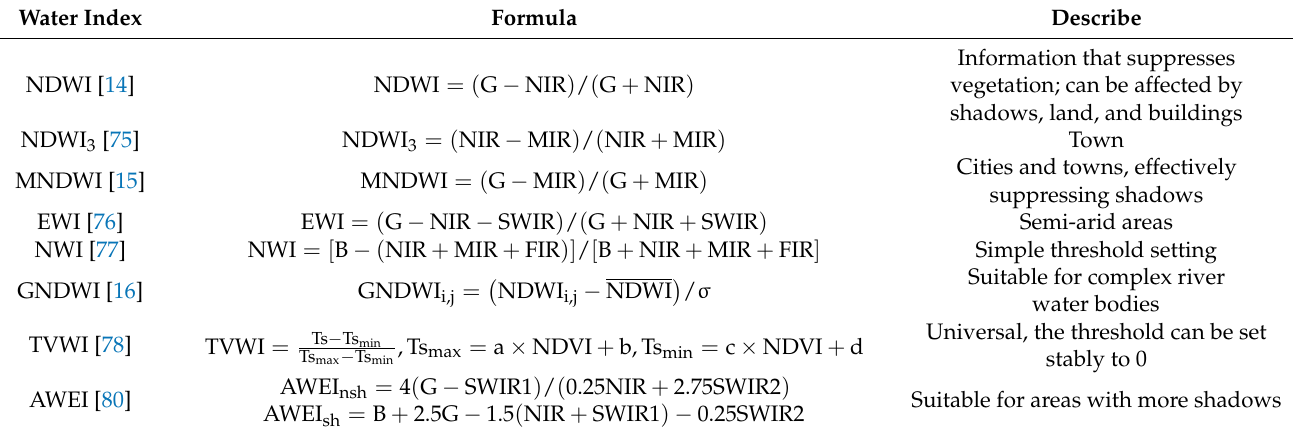
Table 3. Several common water spectral